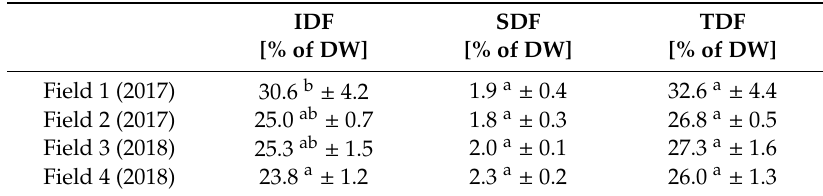
Table 1. Total content of dietary fiber in broccoli leaves, divided into insoluble (IDF), soluble (SDF) and total (TDF) dietary fiber. TDF was calculated as the sum of IDF and SDF. IDF SDF TDF [% of DW] [% of DW] [% of DW]